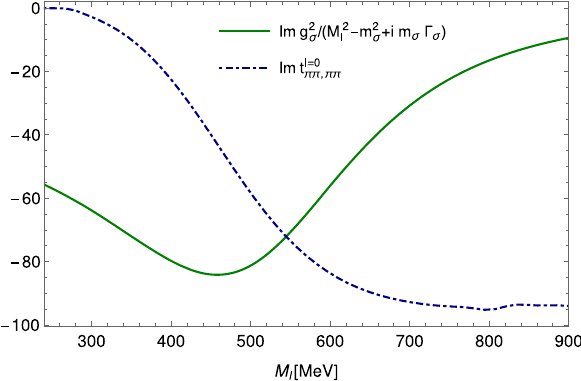
− m 2 + im σ (cid:8) σ ) σ I